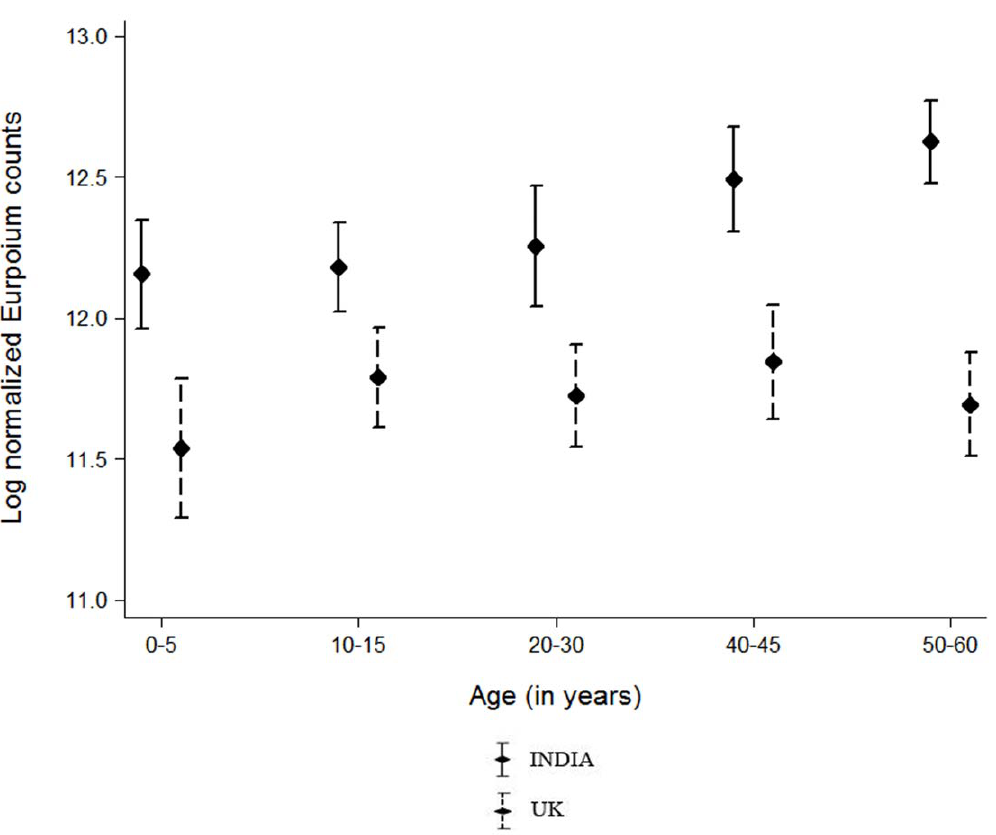
Figure 2. Distribution of log normalized Europium counts among the different age strata in India and the UK. The dots in the center represent the mean Europium counts for that age group whereas the horizontal error bars represent + 2 standard deviations. Europium counts were measured by time resolved immunofluresecence assay.